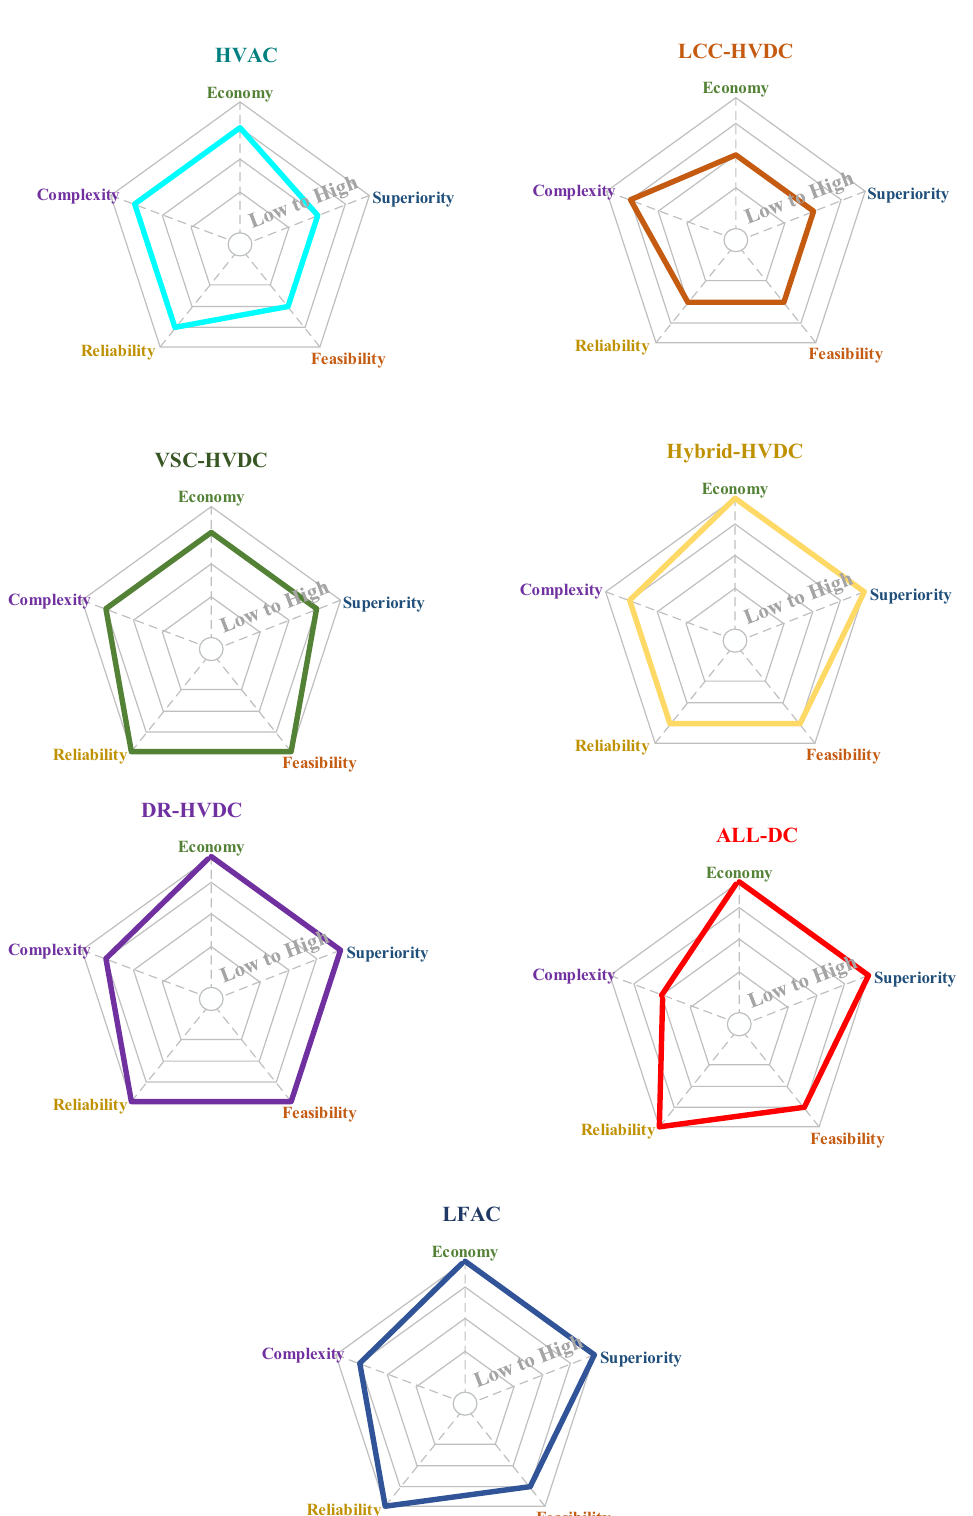
Fig. 21 Evaluation of characteristic for existing OWFs integration